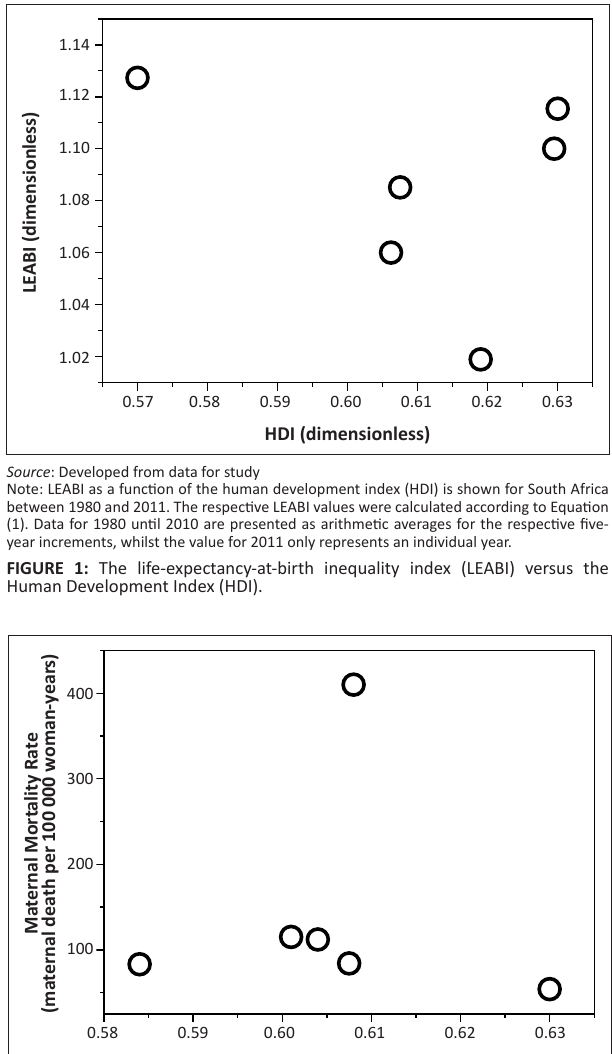
FIGURE 2: Maternal mortality rate versus the Human Development Index (HDI). Gender aspects of the disaster fatalities The respective DRDR values are summarised in Table